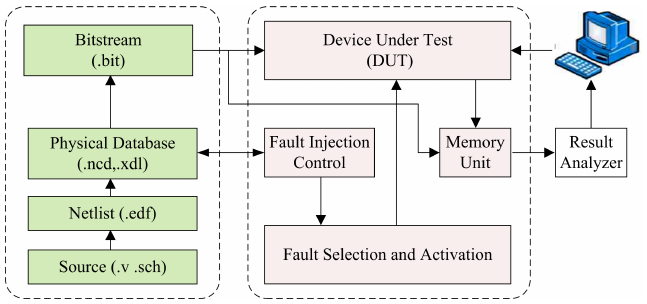
Figure 14. Block diagram of a fault injection system.